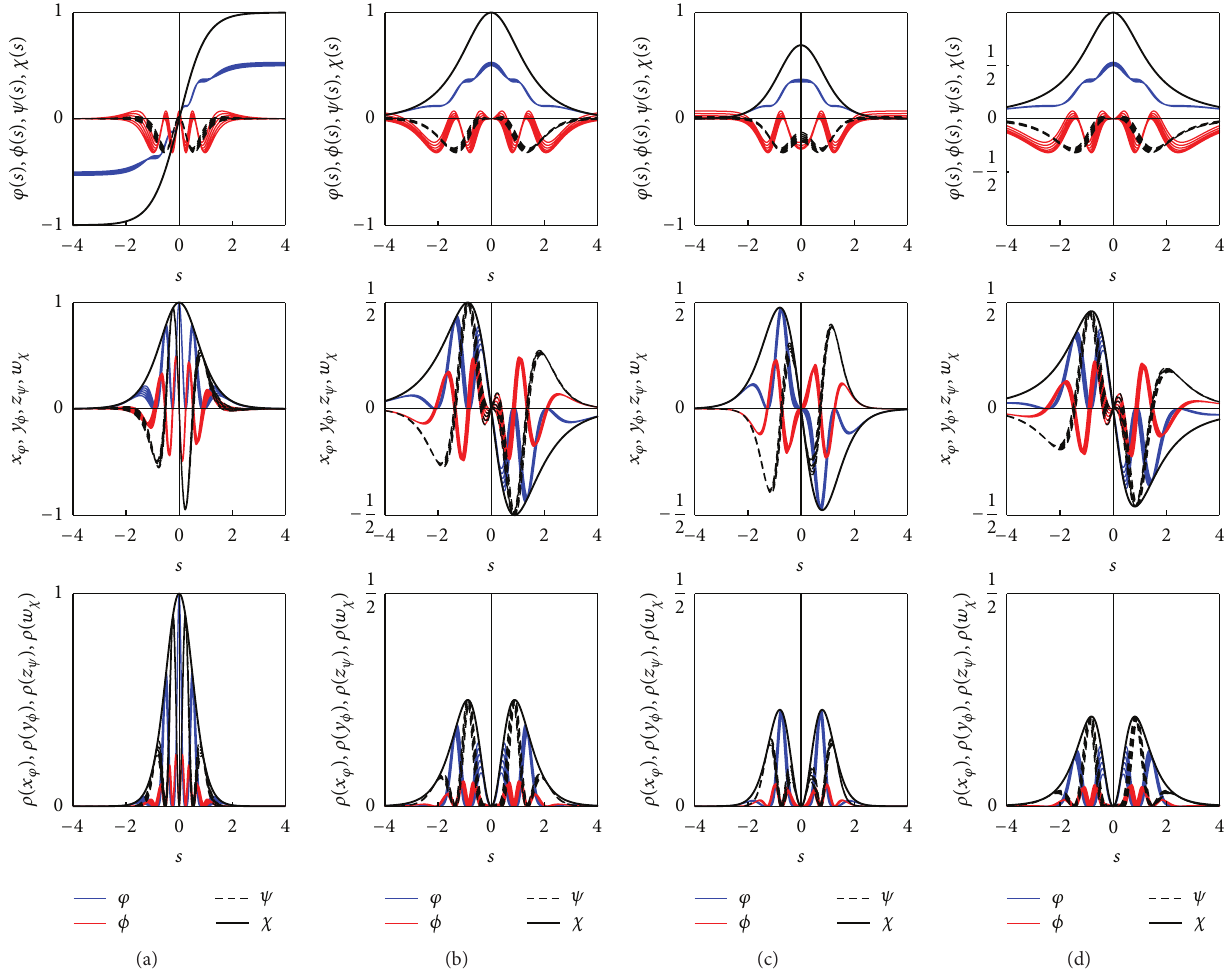
Figure 7: The 4 -cyclica deformed defects obtained from trigonometric deformation functions. Results from each column are again triggered by solutions for 𝜒(𝑠) , in correspondence with (85)–(88). They are in correspondence with those from Figure 6. We have set 𝑛 = 𝑘𝜋/6 with 𝑘 in the range between 12 and 13 , by steps of 0.2 units, in order to depict the oscillatory analytical profile related to 𝑛 , since for 𝑛 ≲ 1 , these plots perturbatively approximate those from Figure